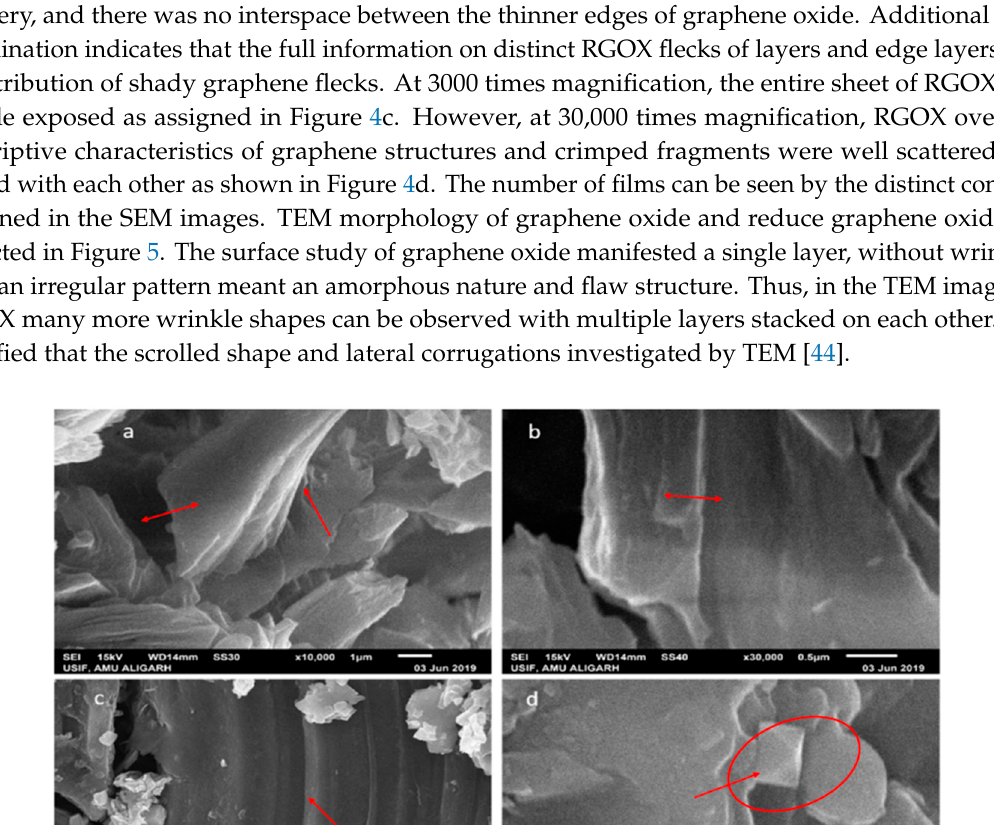
Figure 4. Scanning electron microscopy images at different magnifications ( a ) GOX at 10 K, ( b ) GOX at 30 K, ( c ) RGOX at 3 K and ( d ) RGOX at 30 K.